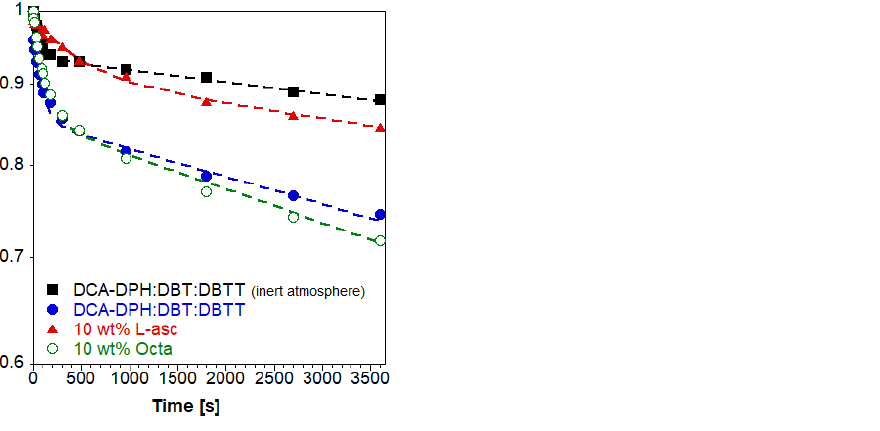
Table 3. PL QY values of as-prepared samples (either prepared in an oxygen-free atmosphere or in air) and after one week of air and light exposure, with and without antioxidants.